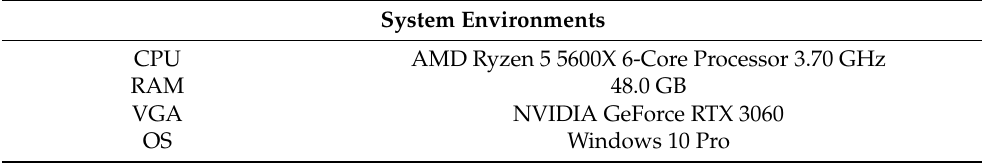
Table 2. System environments.